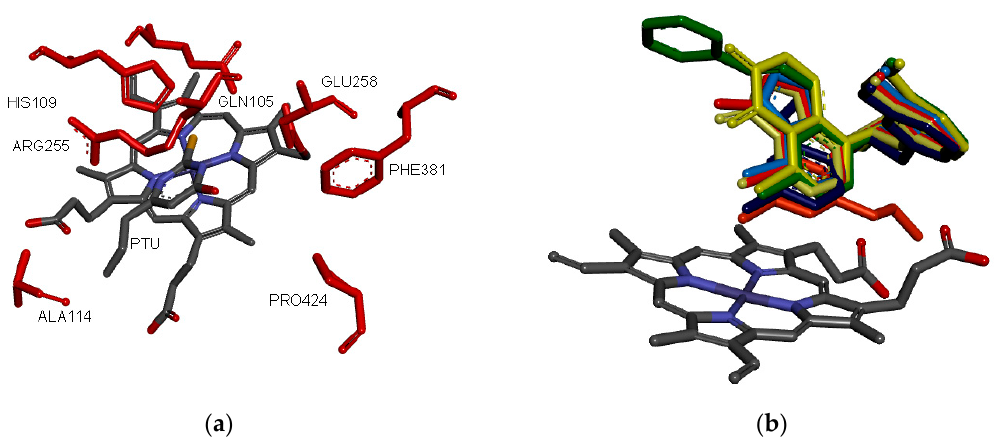
Figure 1. ( a ) Structure of the complex of 6- n- propyl-2-thiouracil (PTU) inbound to lactoperoxidase (LPO). ( b ) The overlaying of the modeled structure of inhibitors 6B , 7B , 9B , 10B , 11B , and the crystal structure of PTU.